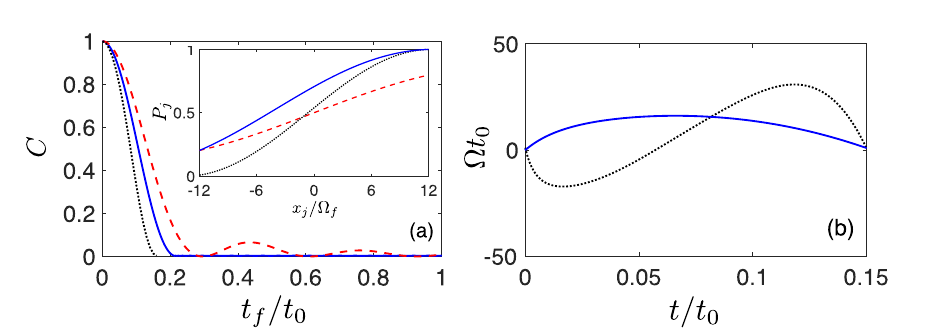
3 i (solid- 0 a i t i = = (cid:31) 3980 (dotted- 50 , a 3 = − = −